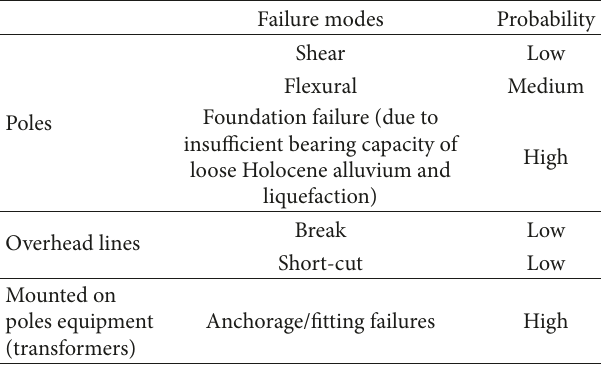
Table 1: Failure modes and approximate failure probability for elementsoflowvoltagedistributionsystemintheconsideredregion.